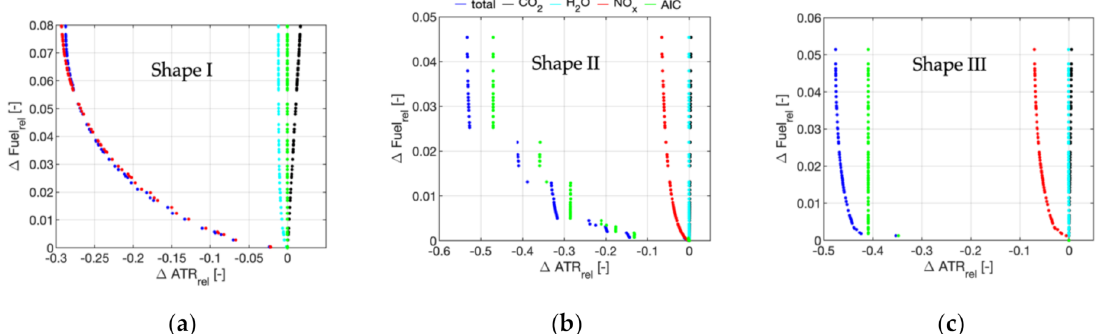
Figure 6. Pareto fronts for Baku–Luxembourg ( a ), Luleå–Gran Canaria ( b ), and Helsinki–Gran Canaria ( c ). The colored dots indicate the individual contribution of CO 2 (black), H 2 O (cyan), NO x (red), and contrails (green) to the overall climate impact reduction (blue) for a given fuel increase. Results are expressed relative to the fuel burn and the total climate impact of the minimum fuel